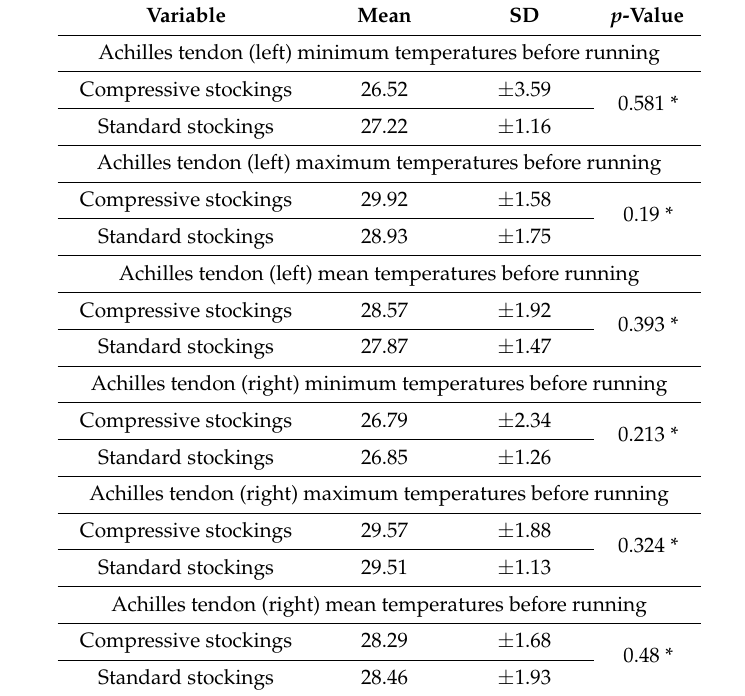
Table 2. Temperature values (degrees Celsius) for Achilles tendons for compressive stocking and standard stocking participants before exercise.